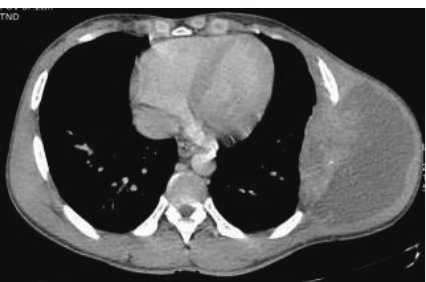
Figure 4: Axial Computed Tomography image at lesion level in mediastinal window showing well loculated hypodense collection in the left chest wall with peripheral enhancement.